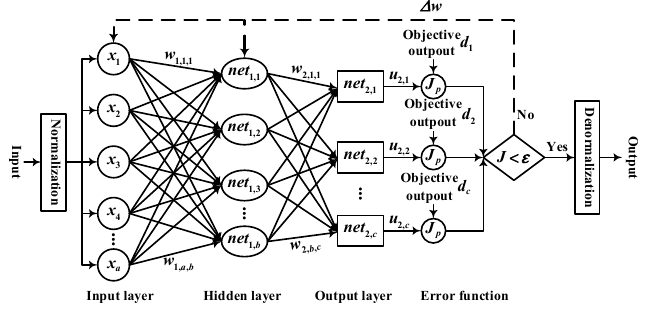
Figure 4. Topological structure and signal flow direction of BP neural network.